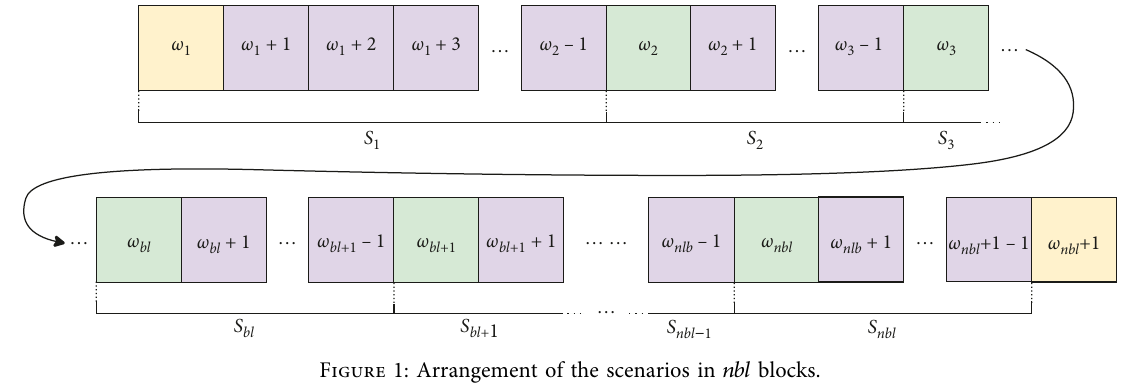
Figure 1: Arrangement of the scenarios in nbl